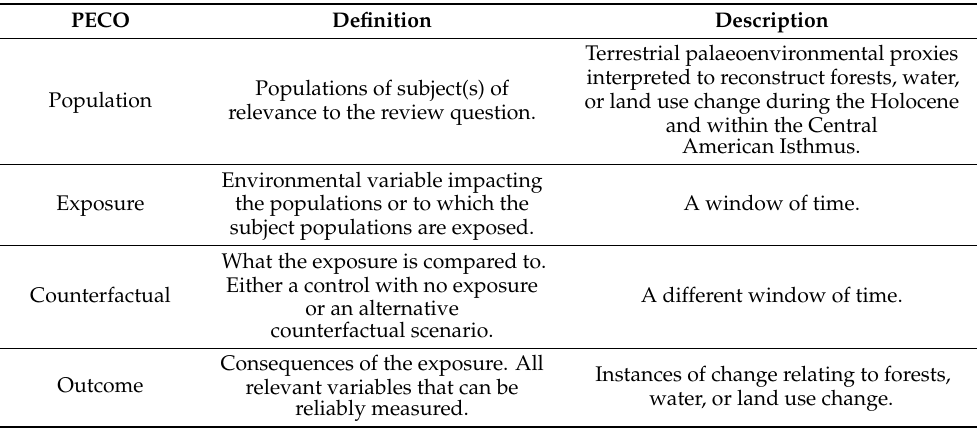
Table 2. Population, Exposure, Counterfactual, Outcome (PECO)